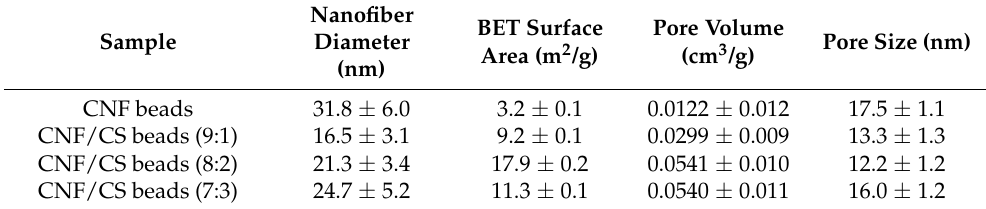
Table 1. Characterization parameters of the obtained